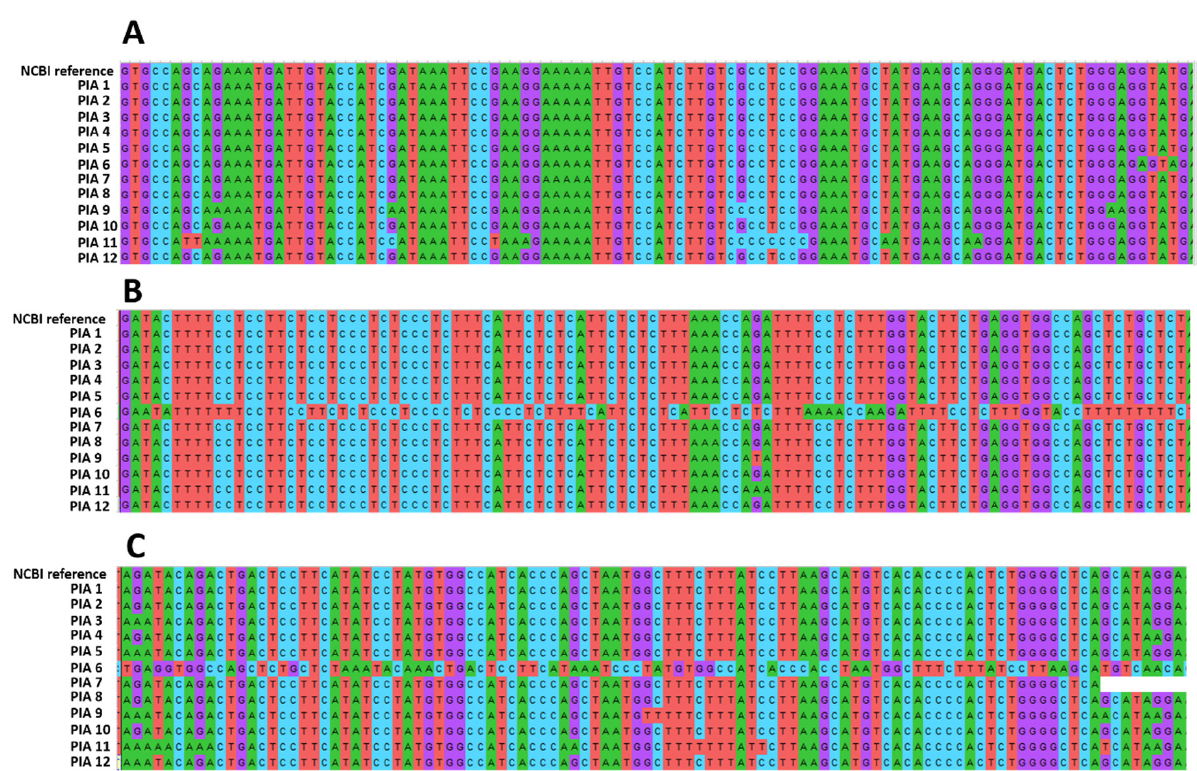
Figure 7. Androgen receptor (AR) sequencing analysis of the 12 proliferative inflammatory atrophy (PIA) samples after alignment. Each figure ( A – C ) represents different regions of the AR gene alignment. There are six samples containing mutations, with PIA 6 representing the samples with a higher number of nucleotide modification. ( A , B ): sequencing alignment showing mutations in PIA6, PIA9 and PIA 11 samples. C: Sequencing alignment evidencing mutation in the samples PIA3, PIA4, PIA5, PIA6, PIA9, PIA11.